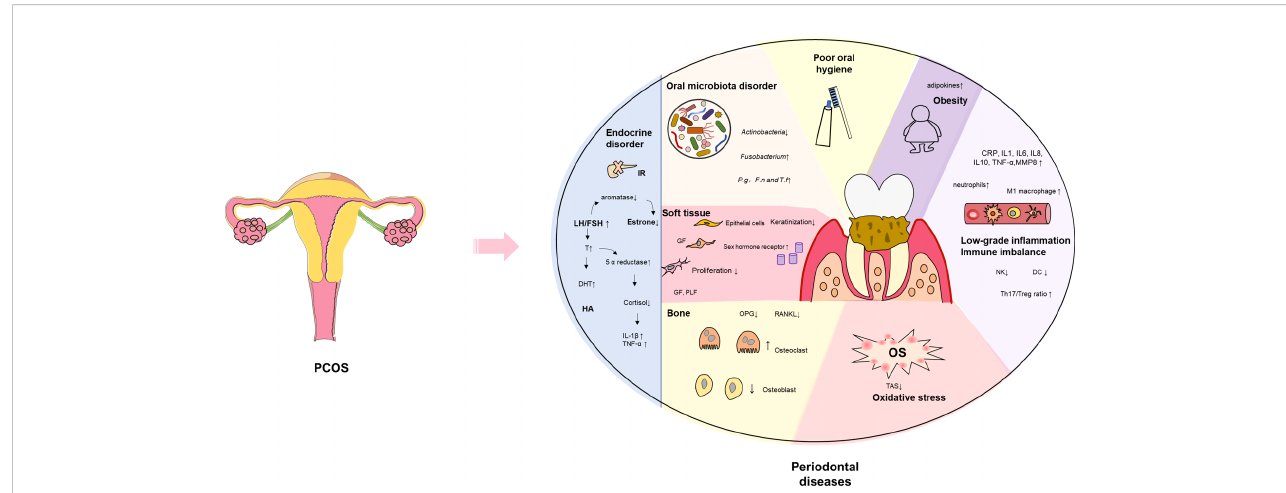
FIGURE 1 Schematic representation of the association between PCOS and PDD. PCOS is characterized by low-grade in fl ammation, immune imbalance, endocrine disorder, and oxidative stress. The above microenvironment has an adverse implication for oral microbiome, periodontium, and alveolar bone. In addition, PCOS women show a propensity for obesity and have a poor oral hygiene, which increases the risk of PDD. PCOS, polycystic ovary syndrome; T, testosterone; DHT, Dihydro testosterone; HA, hyperandrogenism; IR, insulin resistance; LH/FSH, luteinizing hormone/follicle stimulating hormone; F.n , Fusobacterium nucleatum ; P.g , Porphyromonas gingivalis ; T.f , Tannerella forsythia; GF, gingival fi broblasts; PLF, periodontal ligament fi broblasts; OPG, osteoprotegerin; RANKL, receptor activator of NF- k B ligand; MDA, malondialdehyde; MPO, myeloperoxidase; No, nitric oxide; TAS, total antioxidant